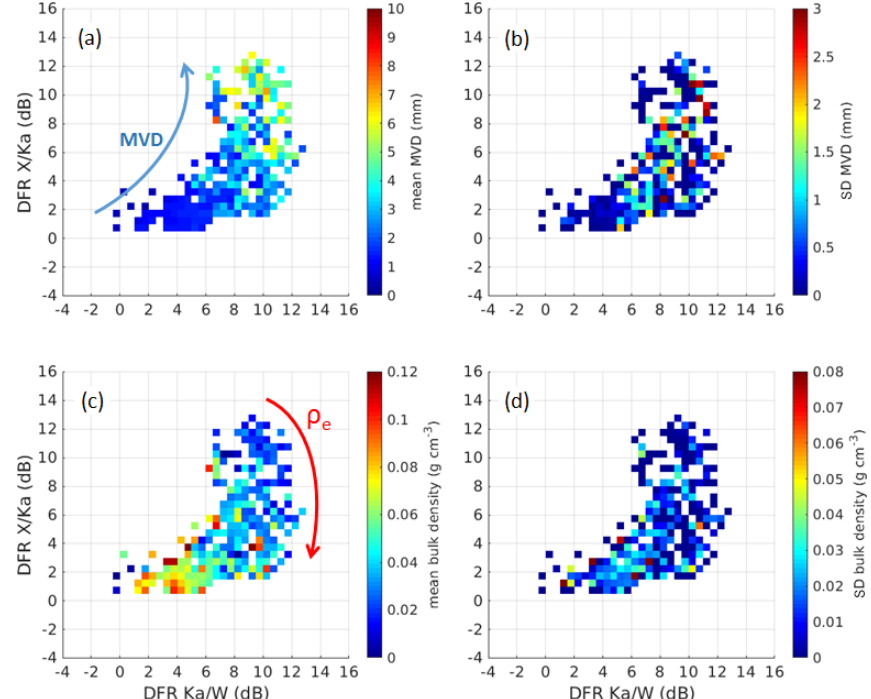
Figure 16. (a) Mean MVD, (b) standard deviation (SD) of MVD, (c) mean ρ e , and (d) SD of ρ e calculated from all the data points (573 sam- ples) analyzed in three study cases for the 22 November flight. The data are binned onto a grid with a grid size of 0.5dB in both axes. The mean and standard deviation are computed from the data within the